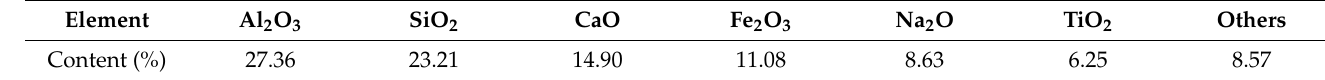
Table 1. The main chemical composition of red